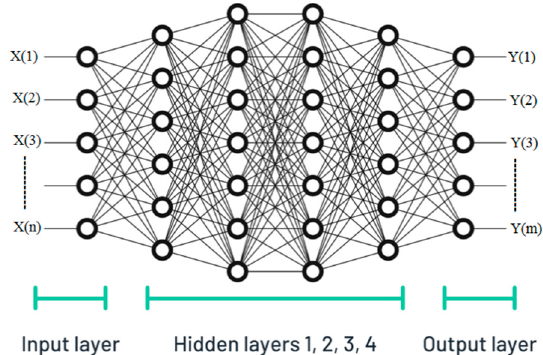
Figure 8. Multi-layer Neural network Setting.